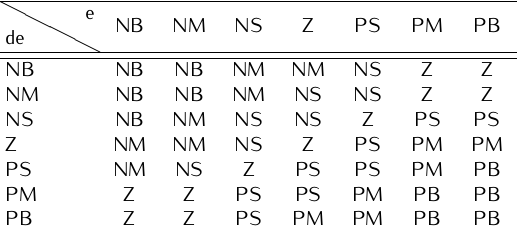
Table 2. The rule base for K